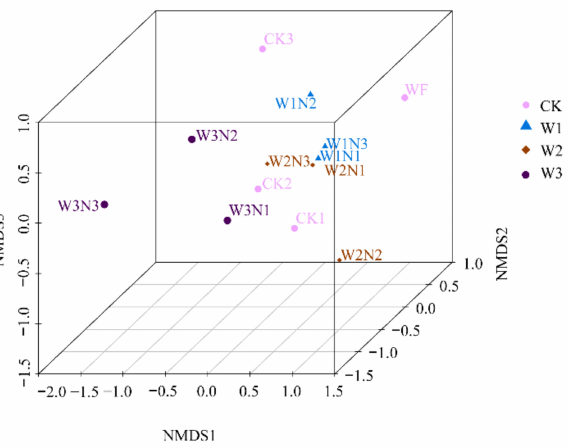
Figure 7. Beta diversity analysis of each treatment. Note: The horizontal and vertical axes represent the two eigenvalues that can best reflect the variance. Each point in the graph represents a sample. Similar samples are clustered together, and if the differences between samples are large, they will be farther apart in the graph. Table 3. Alpha diversity index of soil bacteria and fungi in each group. Chao1 Index Shannon Index Simpson Index Group Bacteria Fungi Bacteria Fungi Bacteria Fungi W1 6423.83 Aa 417.34